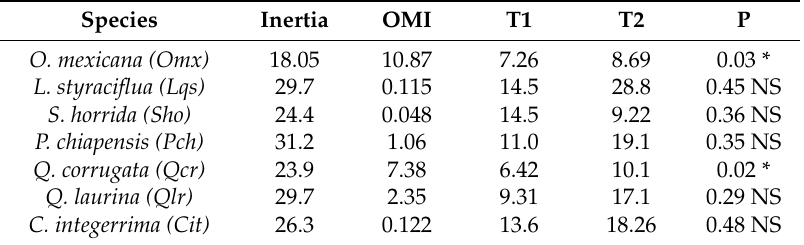
Table 1. Niche parameters of O. mexicana and associated species in the Sierra Ju á rez, Oaxaca.